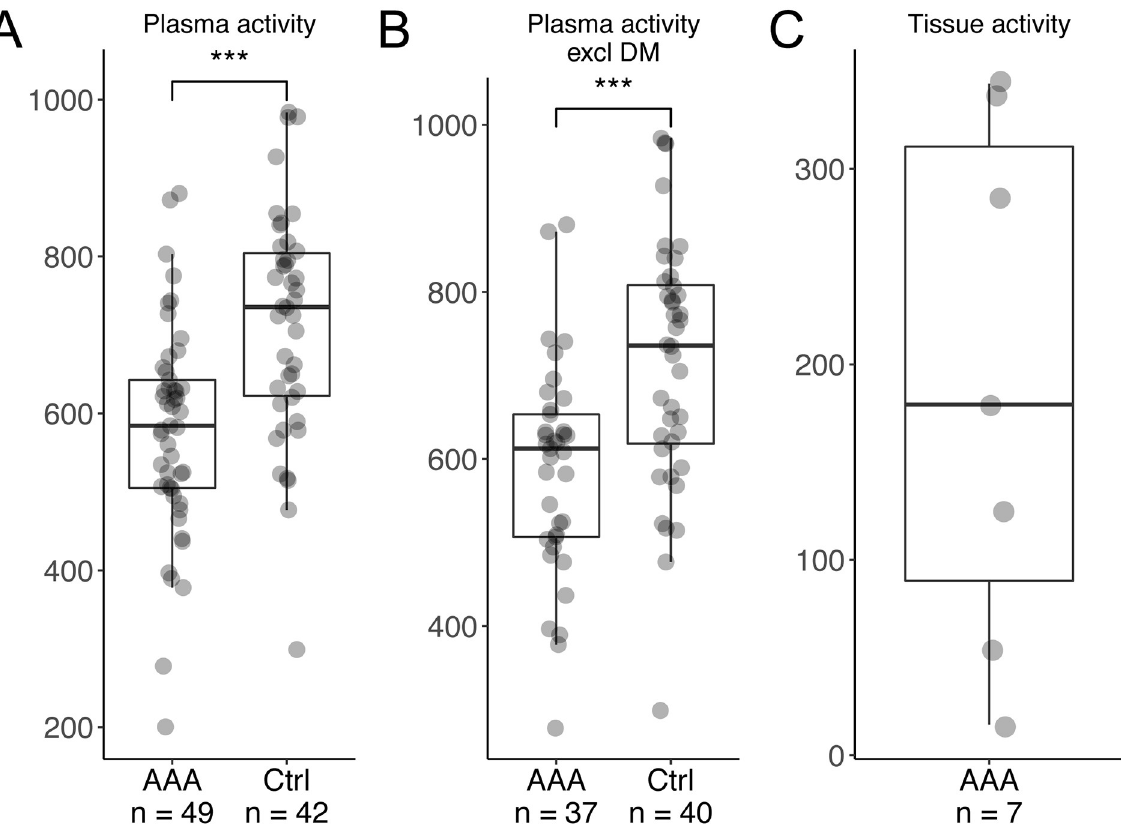
Fig 2. DPP4 activity in plasma. A and B: DPP4 activity in plasma from patients with AAA compared with age-matched controls; with diabetic patients and controls included (A) and excluded (B). C: DPP4 activity in the thrombus-covered wall. Abbreviations: AAA; abdominal aortic aneurysm, Ctrl; controls, DM: diabetes mellitus. � ; p < 0.05, �� ; p < 0.01, ��� ; p <